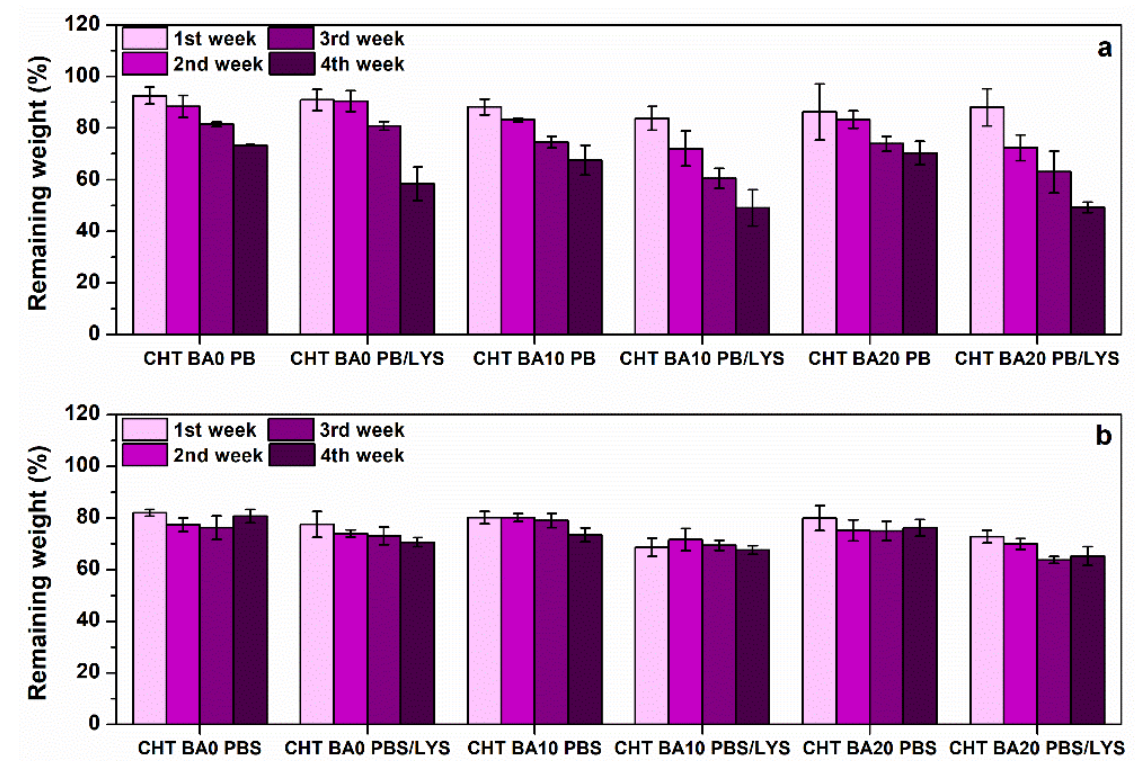
Figure 4. Enzymatic degradation of chitosan-boric acid scaffolds in ( a ) phosphate buffer (pH 6.0) and ( b ) phosphate buffered saline solution (pH 7.4) with and without